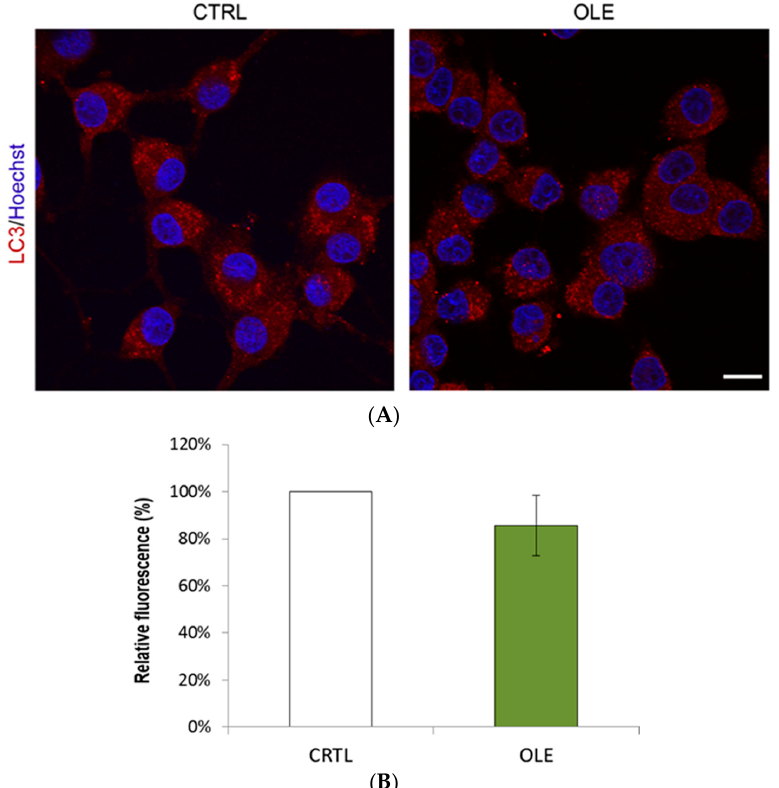
Figure 4. OLE administered alone does not affect the amount of LC3-II-positive vesicles. ( A ) Representative microphotographs show similar numbers of fluorescent vesicles between CTRL and neuronal PC12 cells treated for 3 h with 10 − 12 M OLE alone, as revealed by LC3-II immunofluorescence (red). Nuclei were counterstained with Hoescht 33342. Scale bar = 10 µm; ( B ) Histogram represents semi-quantitative measures of LC3-II red fluorescence. OLE and CTRL show no significant differences. These results were further supported by measuring protein expression of LC3. Lipidated LC3 (LC3-II) is observed as a faster migrating band by Western blotting compared to the non-lipidated form (LC3-I). Consistent with immunofluorescence data, LC3-II levels were similar in control and OLE-treated cells (Figure 5A, CTRL and OLE). Altogether, these results indicate that OLE does not stimulate autophagosome accumulation. In contrast to these results, higher doses of OLE have previously been suggested to induce autophagy [40]. Therefore, to clearly establish the role of OLE in the regulation of autophagy, we measured autophagic flux. During the autophagic process, a portion of LC3-II associated with the autophagosome is degraded in lysosomes along with the